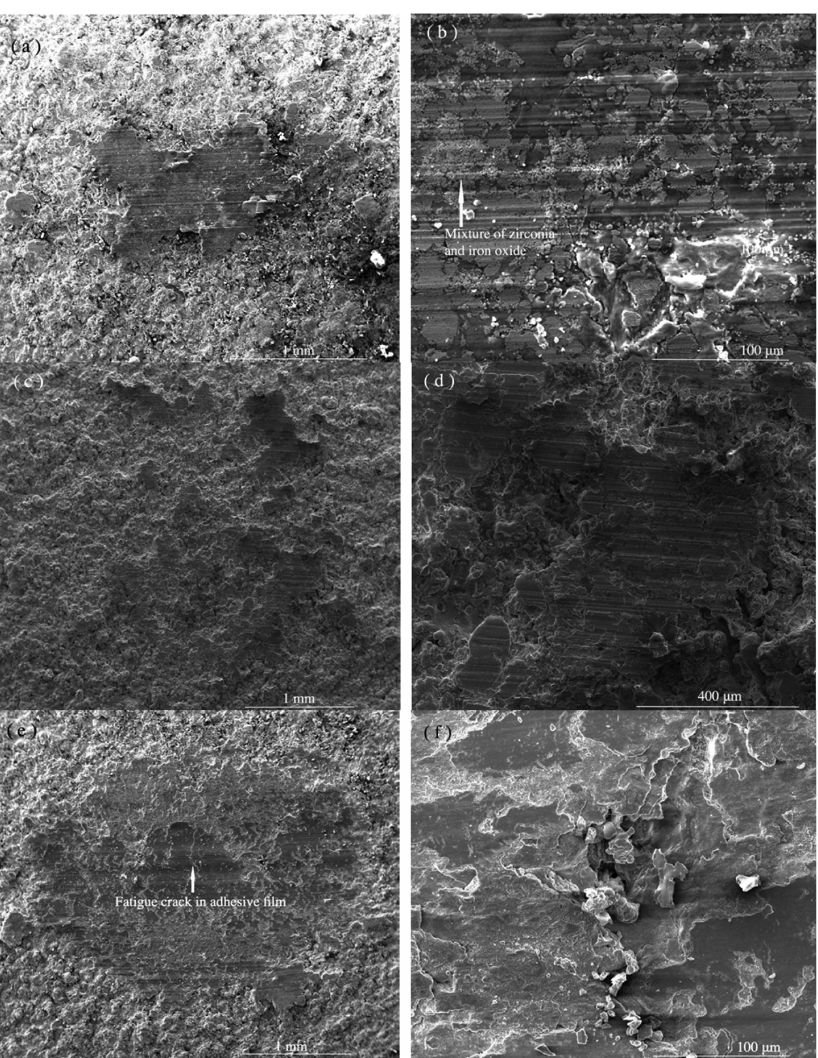
Figure 13: Worn surface morphologies